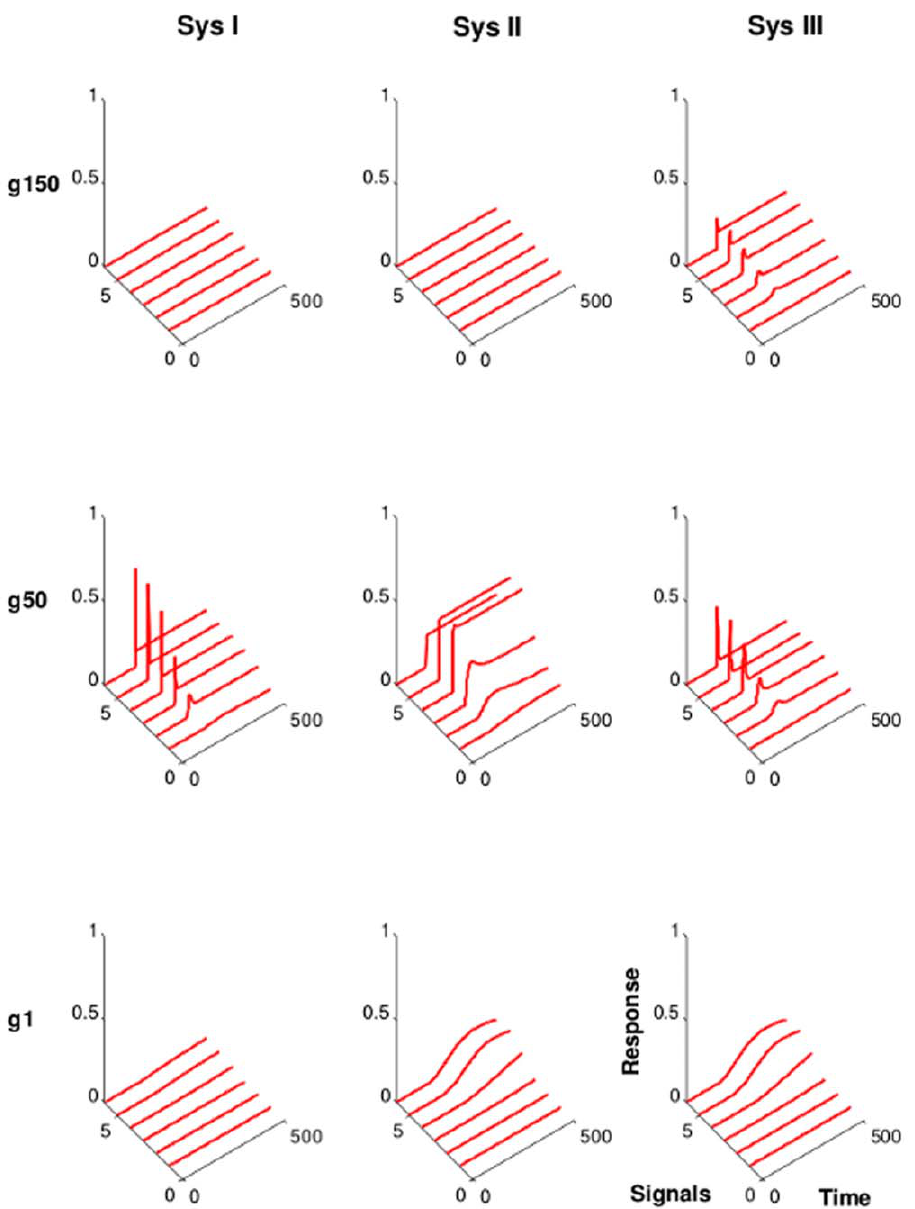
output node in response to six different input signal strengths (strength increases with signal index). Sys I, weak interactions ( k v 10 ). Sys II, moderate interactions ( k v 30 ). Sys III, strong interactions ( k w 30